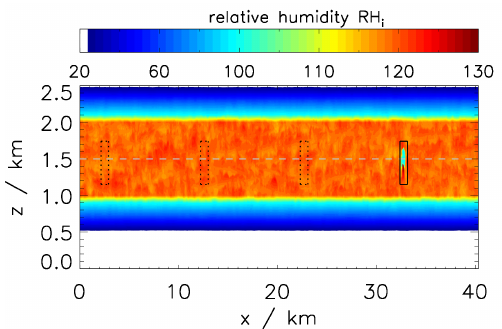
Figure 3. Initial RH i field with the embedded vortex phase simulation result inside the 760m × 600m large black box. The dotted black boxes show alternative positions of the inital contrail placement. The grey horizontal line depicts the flight altitude. This example shows a case with RH i,0 ∗ =